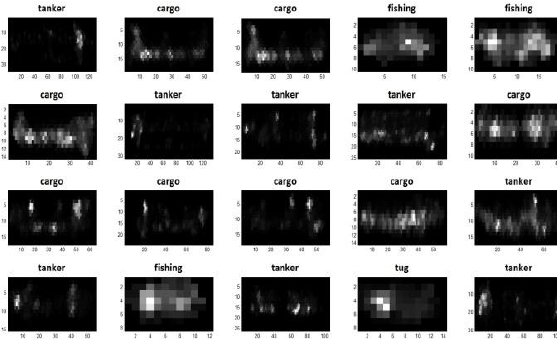
Figure 3. Resulting pre-processed detected